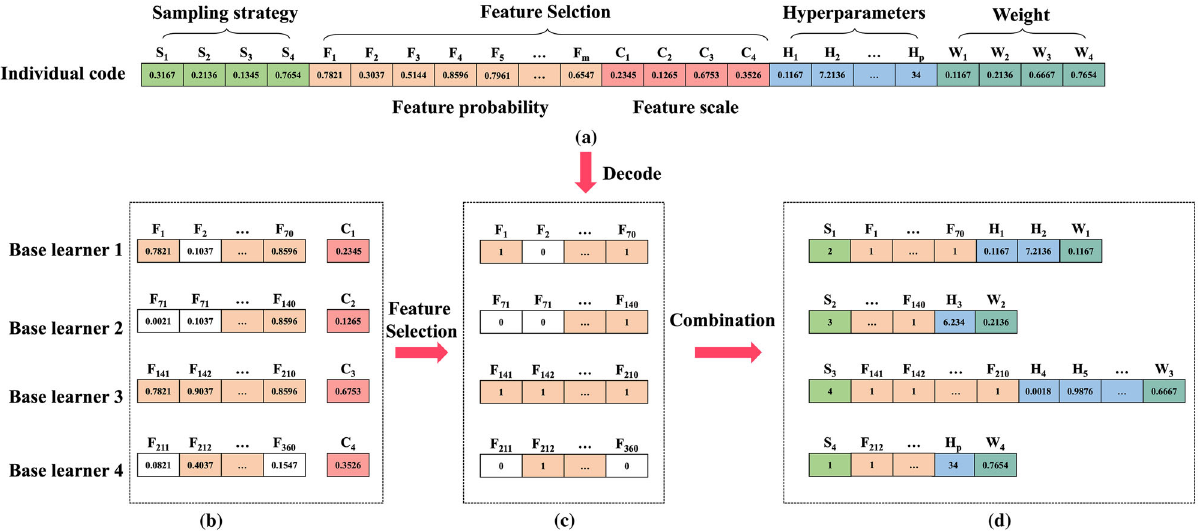
Fig. 13 “ Sampling-feature-hyperparameters-weights ” simultaneous optimization process. a ICHIO consists of a dataset sampling strategy, feature probabilities, feature scales, hyperparameters and weights. b Comparison of feature probabilities ( F m ) and feature scales ( C c ) for each base learner with feature subsets selected depending on the size of the relationship. c The result of feature selection. d Combination of “ sampling-feature-hyperparameter-weight ” and simultaneous optimization to obtain the optimal individual value after several iterations of the objective